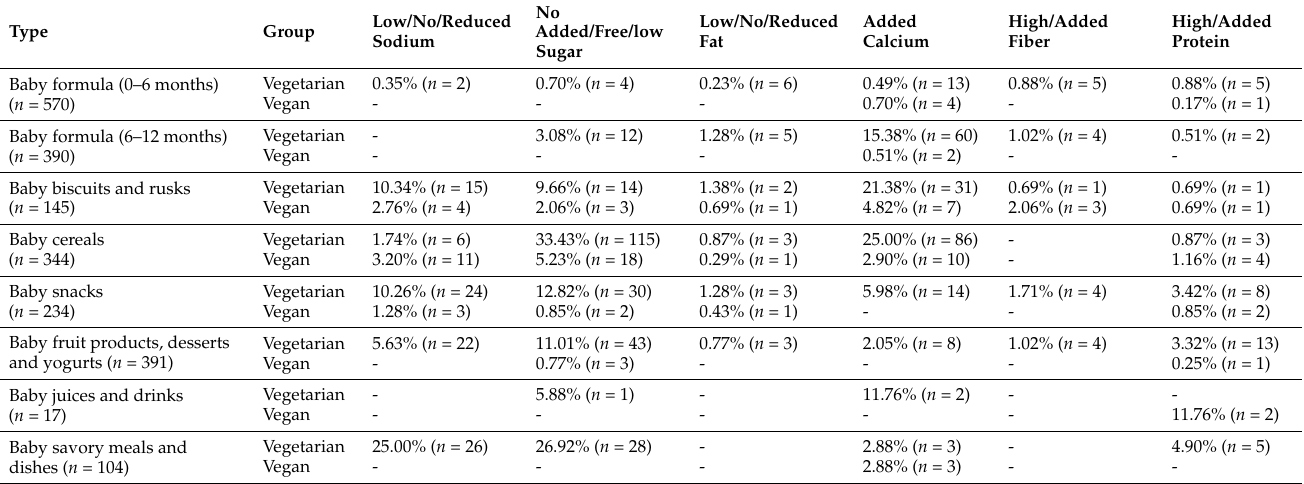
Table 4. Top nutrition claims of infant foods (expressed in percentage out the total of product